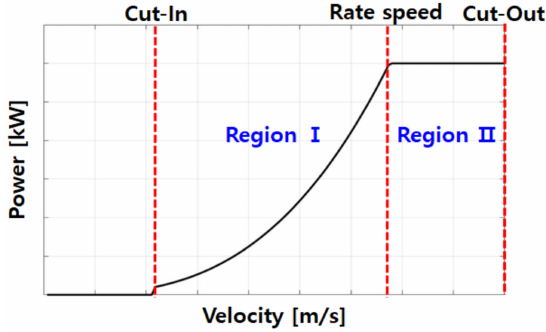
Figure 7. Power curve of